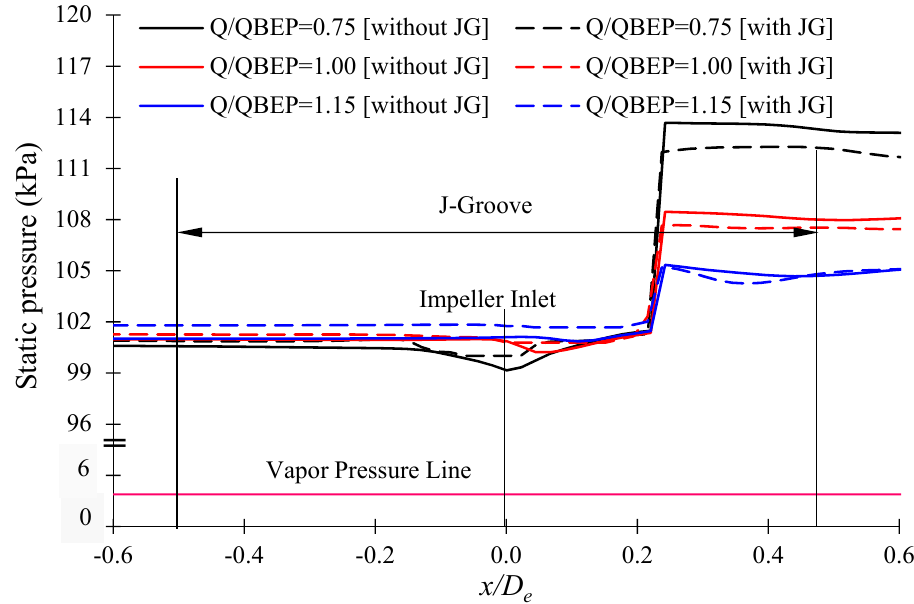
Figure 13. Pressure distribution comparison in the SCP model without and with J-Groove. The suction performance of the AJP model without and with initial J-Groove is shown in Figure 14. The suction performance is directly affected by the pressure distribution. The critical cavitation numbers are 0.19, 0.30 and 0.38 at q = 0.4, 0.5 and 0.6, respectively. The installation of J-Groove improves the suction performance in the AJP model. The critical cavitation number is improved from 0.38 to 0.30, 0.30 to 0.24 and 0.19 to 0.18 at q = 0.6, 0.5 and 0.4, respectively. Hence, the installation of J-Groove drastically improves the suction performance of the AJP model.